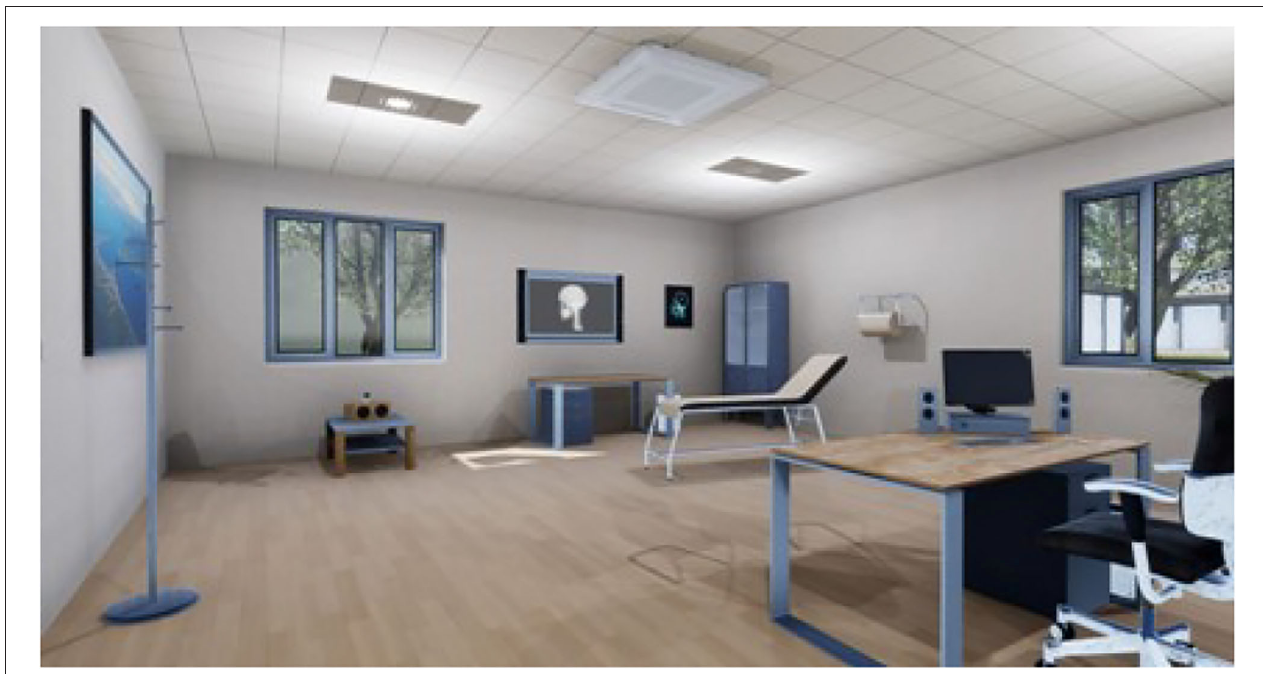
FIGURE 1 | Medical Psychological Office.